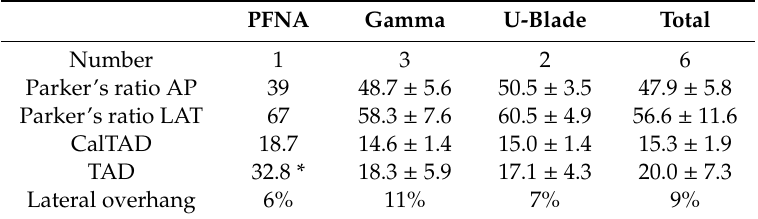
Table 3. Lag screw / blade position in the femoral head and neck fragment of patients sustaining Table 3. Lag screw/blade position in the femoral head and neck fragment of patients sustaining a cut- a out. PFNA